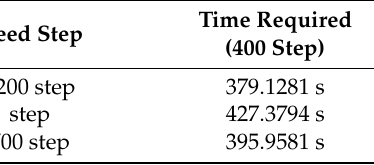
Table 5. Summary of 10 × 10 learning